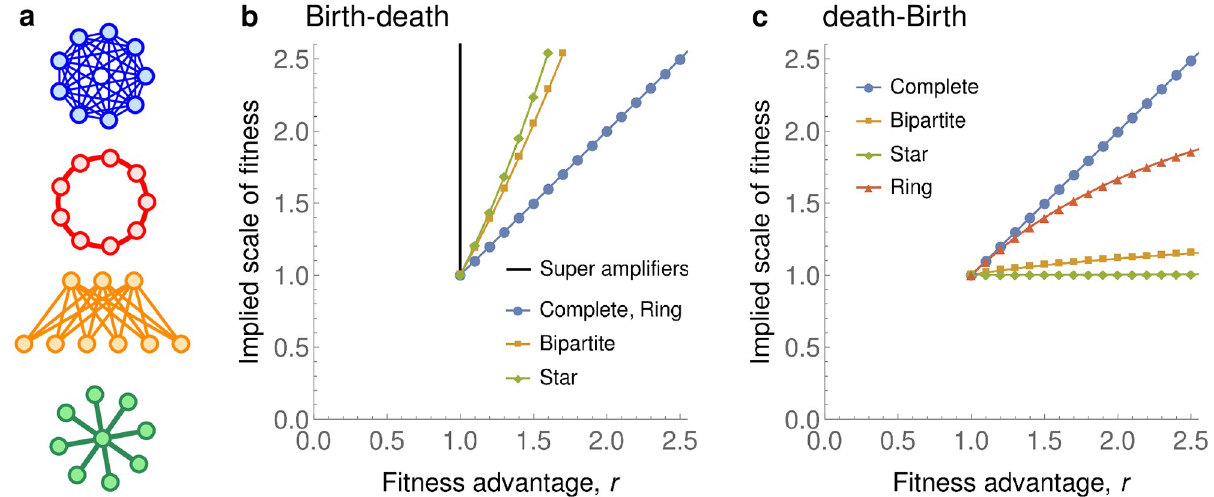
Fig 3. Implied scale of fitness. The implied scale of fitness for several graph families. a , Complete graphs K N , Ring graphs R N , complete Bipartite graphs ffiffiffi p p and Star graphs S N . b , Under Birth-death updating, the Star graphs and the Bipartite graphs are quadratic amplifiers, whereas the Ring graphs B ffiffiffi ; N (cid:0) N N are equivalent to Complete graphs. There also exist super amplifiers that guarantee fixation with probability 1 for any r > 1. (To model the limit N ! 1 we show values for N = 400.) c , Under death-Birth updating, none of Bipartite graphs, Star graphs or Ring graphs amplify selection.